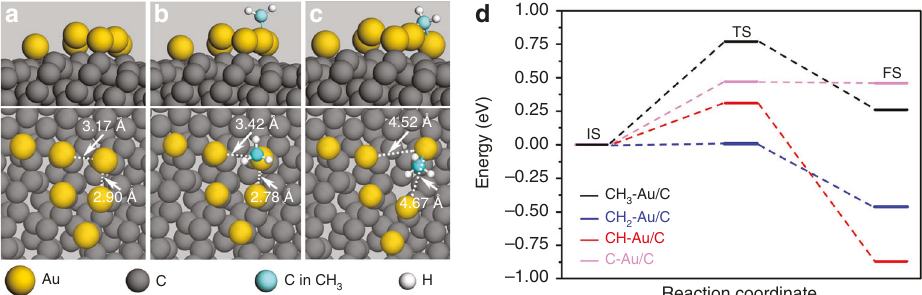
Fig. 4 DFT-calculated con fi guration evolutions of an Au cluster on an amorphous carbon. a DFT-relaxed atomic con fi guration of a pure Au cluster consisting of six Au atoms on amorphous carbon, which is denoted as Au/C. The top and the bottom panels are the side and the top views of the con fi guration, respectively. b , c DFT-relaxed atomic con fi gurations of the IS ( b ) and the FS ( c ) of CH 3 – Au/C (see Supplementary Fig. 16 for the con fi gurations of CH 2 – Au/C, CH – Au/C and C – Au/C). CH 3 – Au/C, CH 2 – Au/C, CH – Au/C and C – Au/C denote the con fi gurations of the Au cluster, respectively, with the presence of CH 3 *, CH 2 *, CH* and C*, which are the intermediates and the carbon product of the CH 4 pyrolysis. IS, TS and FS are the initial, the transition and the fi nal states, respectively. The dashed lines pointed by the white arrows in a – c denote the interatomic distances. d Activation energies of the con fi guration evolutions of the Au cluster, in which the black, blue, red, and pink lines represent the corresponding IS, TS, FS and activation energy of the Au cluster evolution under the adsorption of CH 3 , CH 2 , CH, and C,